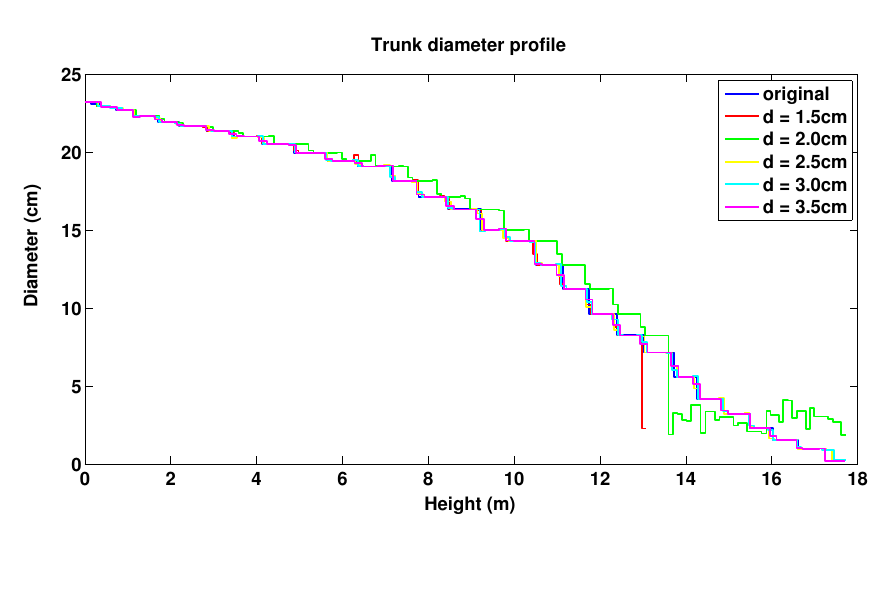
Figure 13. Trunk